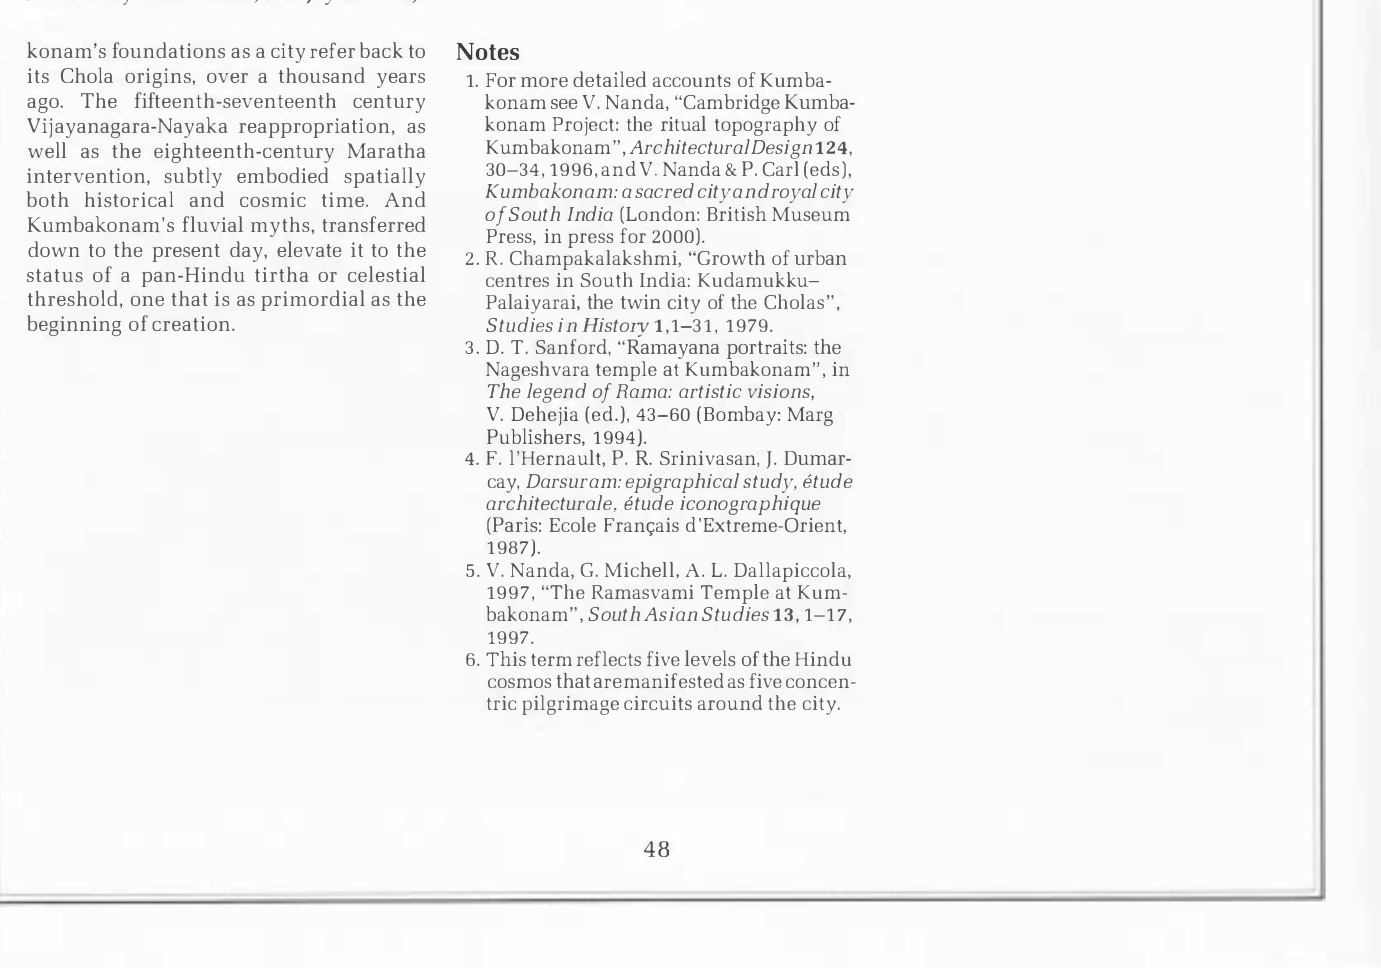
Figure 11 The Mahamakam festival of 1 8 February 1992 at the Mahamakam tank; several hundred thousand pilgrims congregate at the site every 12 years, together with important politicians (the gigantic figure in the background is a wooden cutout of the Chief Minister of Tamil Nadu, Mrs